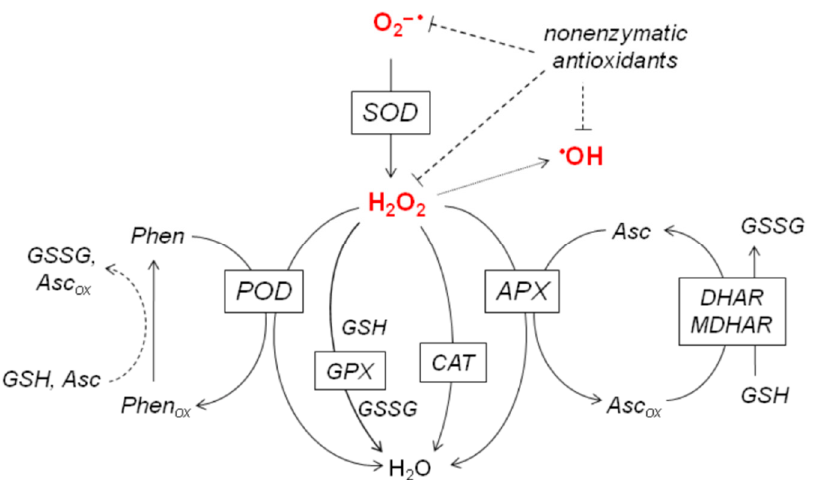
Figure 1. Major antioxidants participating in ROS neutralization. Solid and dashed lines represent enzymes and non-enzymatic reactions, respectively. Nonenzymatic antioxidants include ascorbate (Asc), glutathione (GSH), phenolic compounds (Phen), and several other compounds. Their reaction with ROS is symbolized with bar-ended dashed lines. Superoxide anion radicals O 2 −• are converted to hydrogen peroxide (H 2 O 2 ) by superoxide dismutase (SOD). A dotted arrow shows the possibility of the conversion of H 2 O 2 into hydroxyl radicals ( • OH), which is prevented by the decomposition of H 2 O 2 . H 2 O 2 neutralizing enzymes include ascorbate peroxidase (APX), catalase (CAT), glutathione peroxidase (GSH), and class III peroxidases (POD). Oxidized ascorbate (Asc ox ) is reduced by monodehydroascorbate reductase and dehydroascorbate reductase enzymes, which also produce glutathione disulfide (GSSG). Some oxidized phenolic compounds (Phen ox ) can be recovered by Asc or GSH.